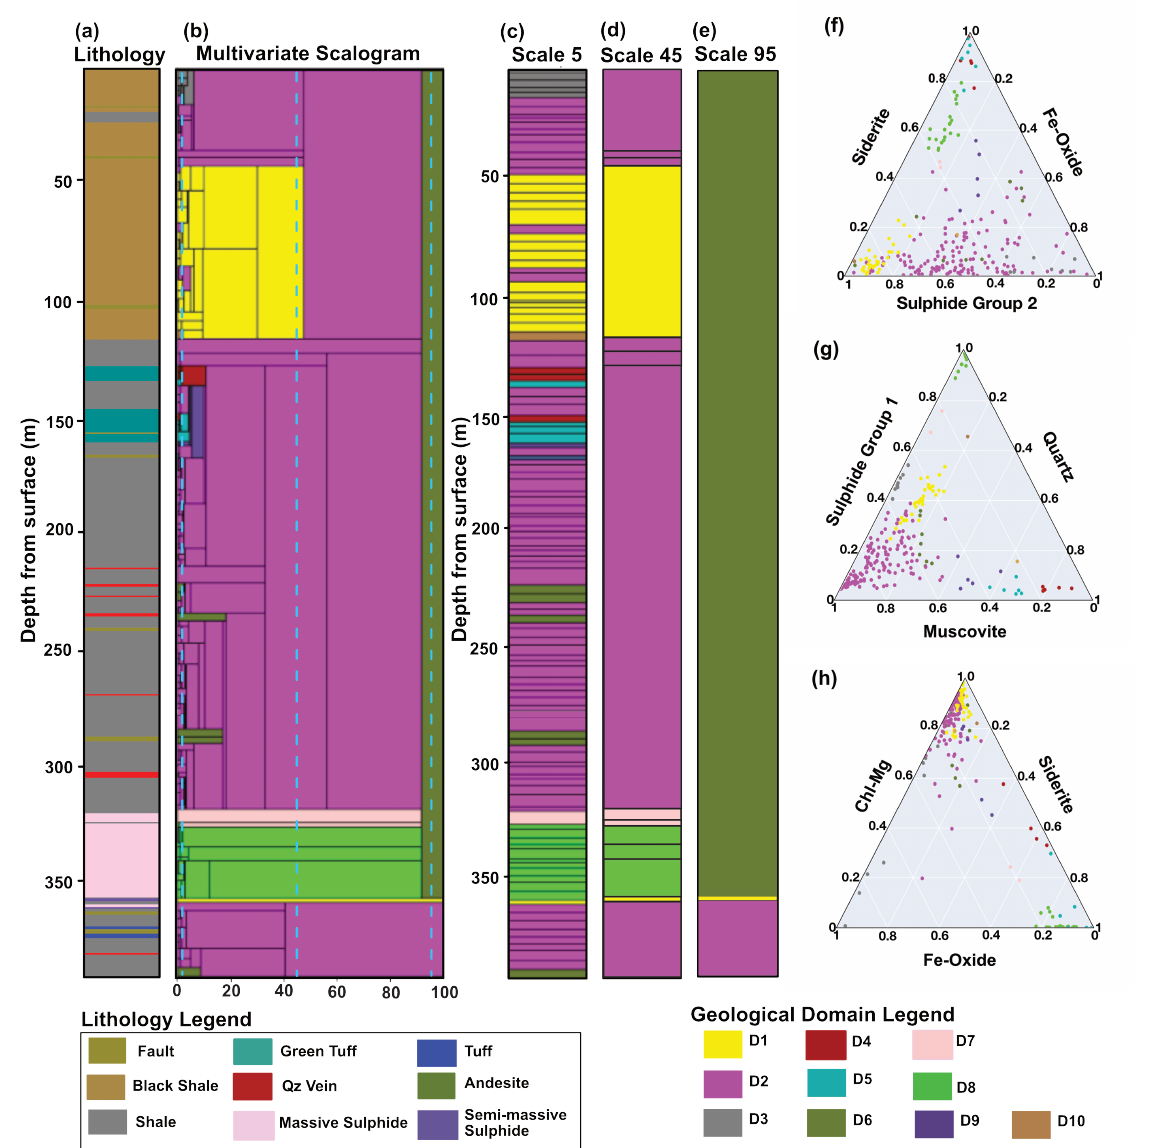
Figure 7. Segmentation and domaining results for borehole ELV-10 of the Elvira deposit. ( a ) Lithological log provided by the mining company. ( b ) Multivariate scalogram and classification results. The three vertical dashed blue lines represent the scale corresponding to panels ( c – e ). ( c – e ) Geological domain classifications for the Elvira-10 borehole extracted from the scalogram at scales of 5, 45 and 95, respectively. ( f – h ) Ternary diagrams showing the average composition of domains in the multivariate scalogram, based on the relative composition of: ( f ) siderite, iron oxide and sulfide group 2. ( g ) sulfide group 1, muscovite and quartz. ( h ) magnesium-rich chlorite, siderite and iron